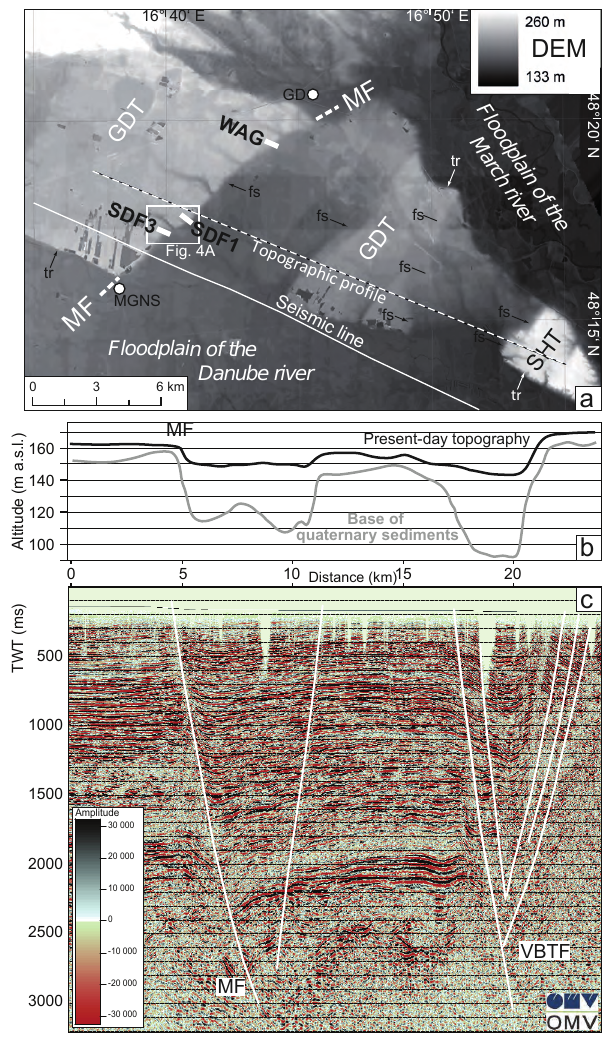
Figure 3. Overview of the Markgrafneusiedl Fault (MF). (a) DEM (10 × 10m resolution, provided by the government of Lower Aus- tria) showing the Pleistocene terraces north of the River Danube dis- sected by faults creating fault scarps (fs). GDT is the Gaenserndorf terrace and SHT is the Schlosshof terrace. Dashed line: trace of the topographic profile in panel (b) ; solid line: trace of the seismic line in panel (c) , white circle: locations of the villages Markgrafneusiedl (MGNS) and Gaenserndorf (GD). (b) Topographic profile (black) and cross section indicating the base of Quaternary sediments (grey) across the MF. Note the thickness of Quaternary growth strata in the fault-delimited basin above the MF. Vertical exaggeration: 8.6 × (c) seismic section across the same area showing offset along the MF and the flower structure at the Vienna Basin Transfer Fault (VBTF). Vertical exaggeration at 2s TWT (two-way travel time) is 4.5 × . See text for details.